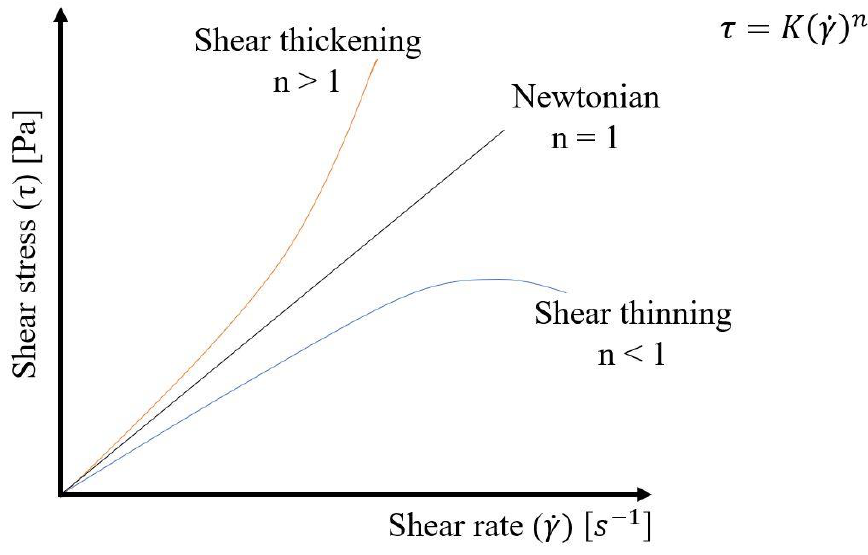
Figure 5. Shear stress vs. strain rate for Newtonian and non-Newtonian fluid.